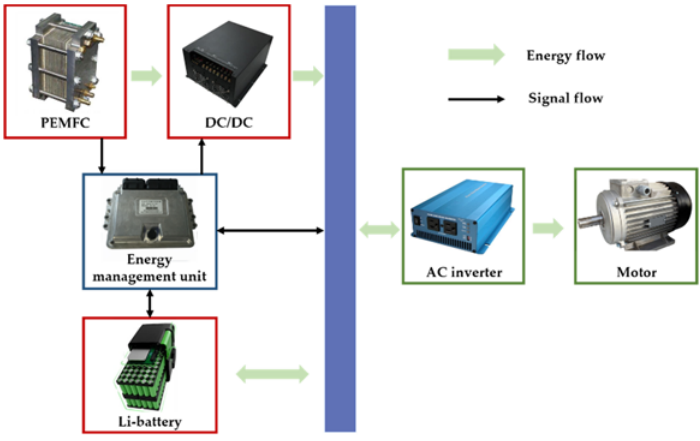
Figure 1. Architecture diagram of the hybrid powertrain system. Table 2. Main parameters of the powertrain system and vehicle.